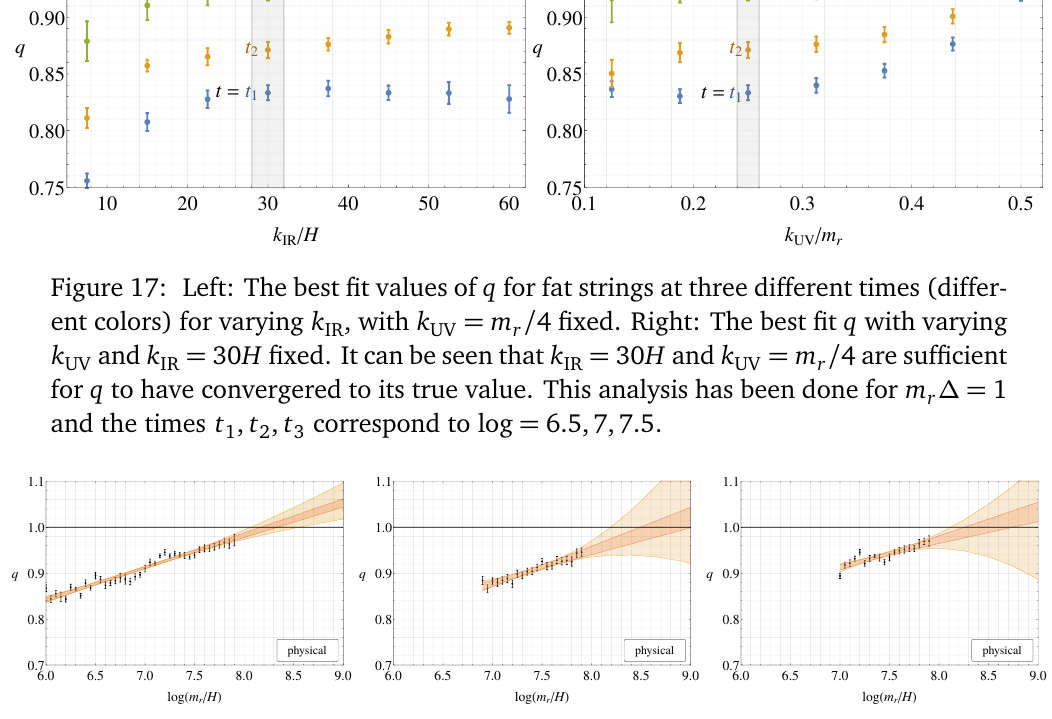
/ 4 ] r ∆ = 1.5. Center: q fit in the range r f / 6 ] for m ∆ = 1.5. r r f